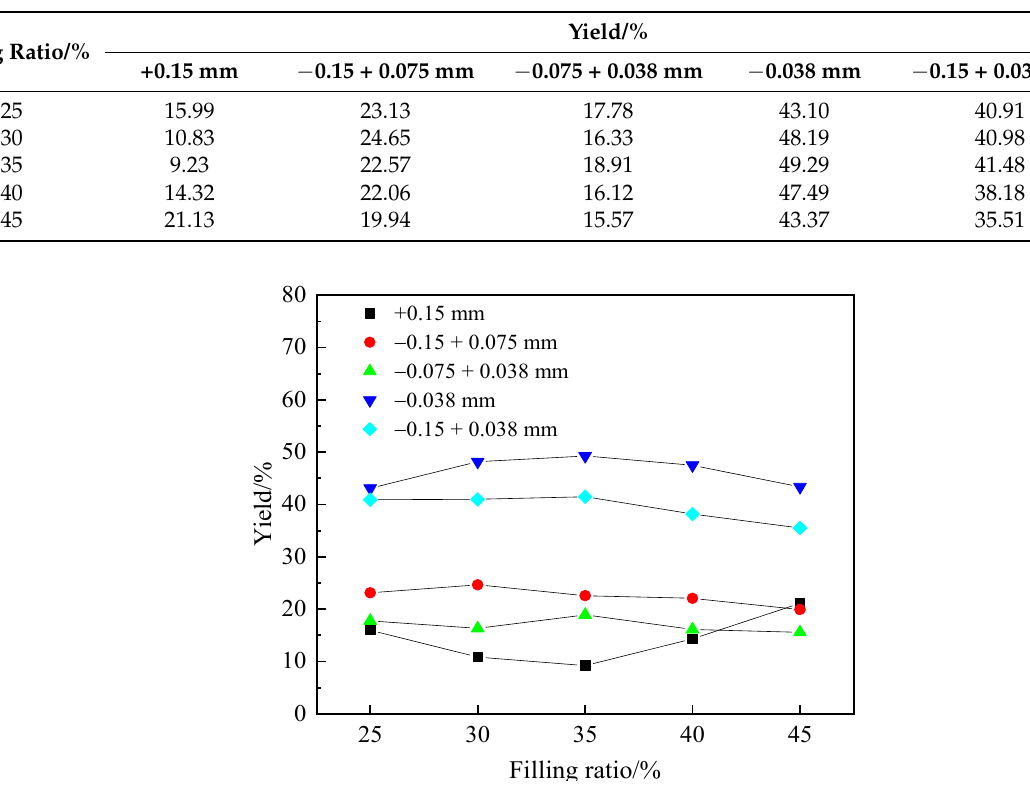
Figure 3. Particle size of grinding product at different filling ratios.